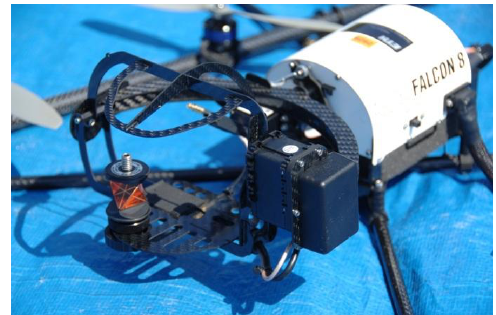
Figure 3: Gimbal of the Falcon 8 system equipped with a 360° mini prism from Leica Geosystems (Bláha et al.